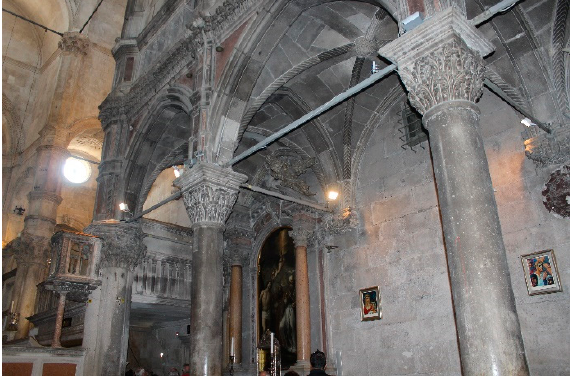
Figure 1. Cathedral of St. James in Šibenik (Croatia). Tie rods are supporting the walls and arches.